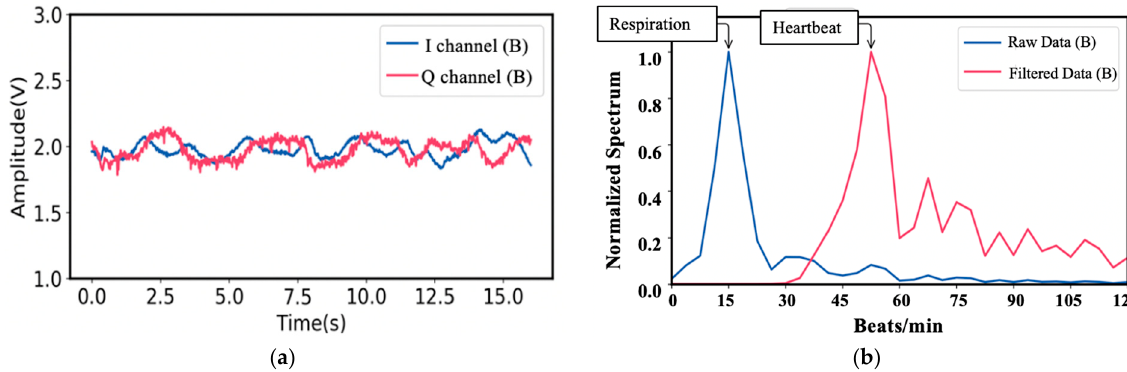
Figure 8. ( a ) Time domain vital sign signal of Target A; ( b ) the measured respiration and heartbeat rates of Target A using MTM LWA-based homodyne radar sensor module band [49].